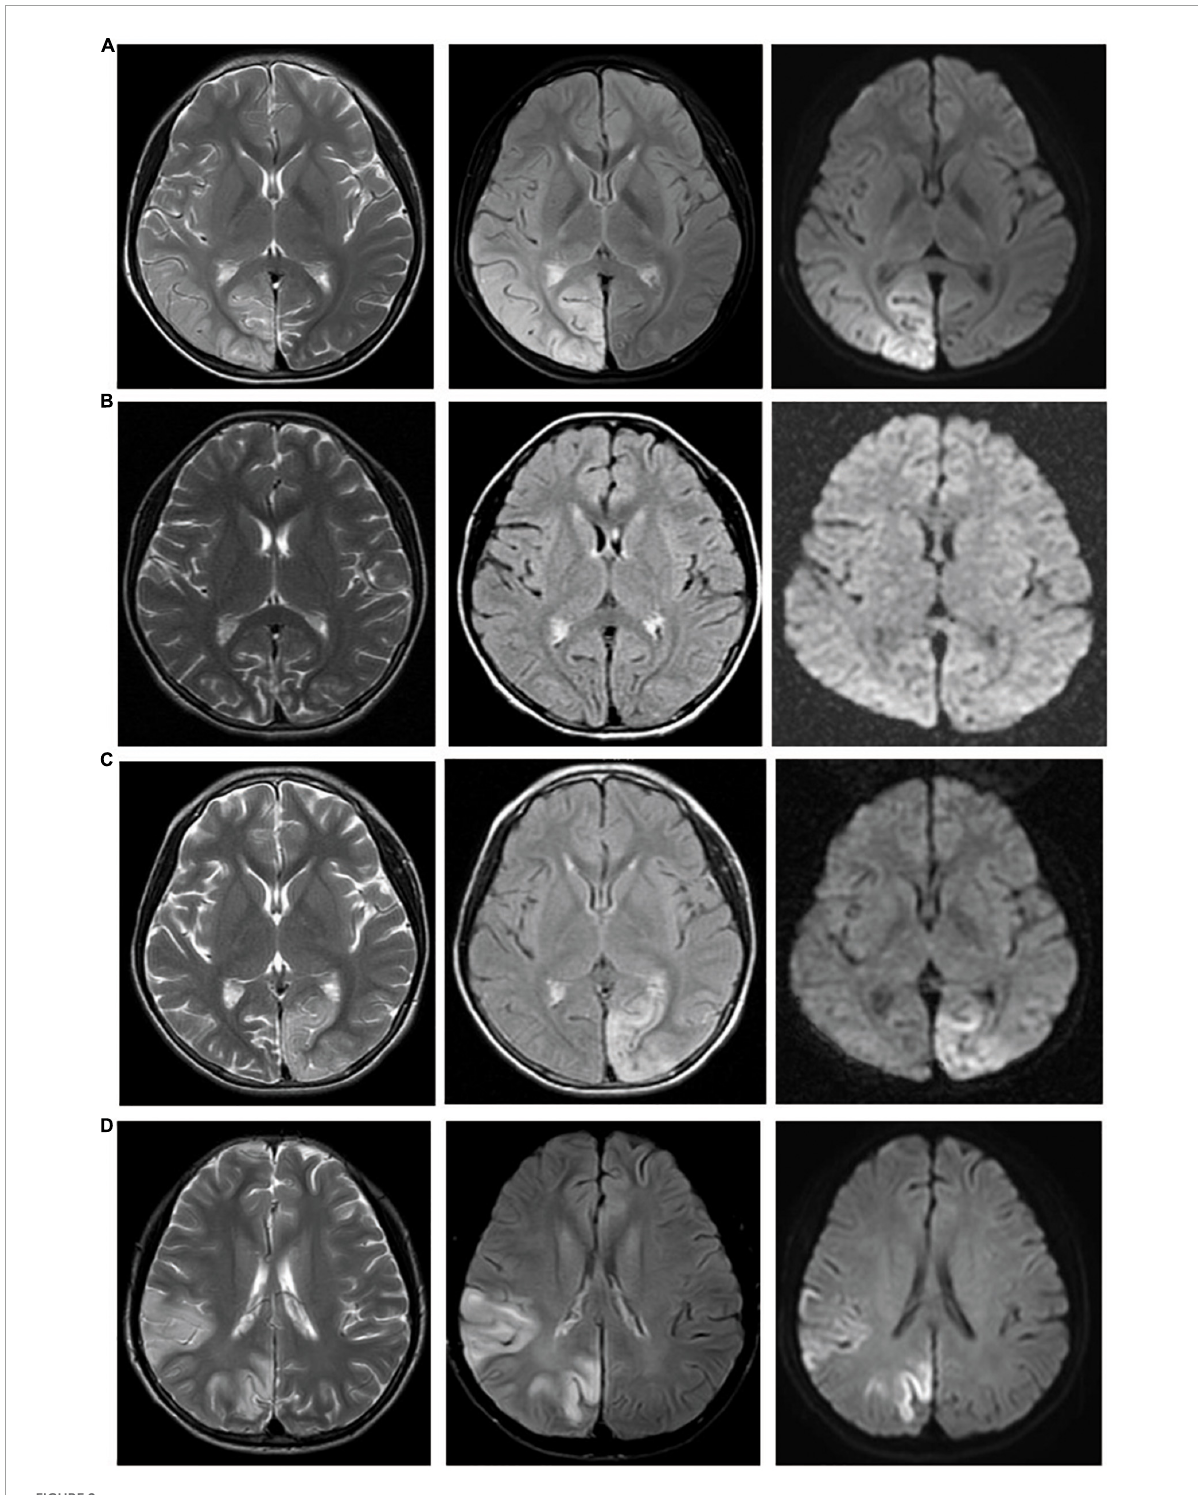
FIGURE2 Lesions migrate over time. Case 6: Four MR examinations were conducted successively in a 10-year-old girl with MELAS from 2014 to 2016. (A) Abnormal signal in the right temporal, parietal, and occipital lobes. (B) Forty-eight days later, MR showed cerebral atrophy, and the abnormal signal in the right temporal, parietal, and occipital lobes disappeared. (C) Eighty-seven days later, a new lesion appeared in the left parietal and occipital lobes. (D) More than 2 years later, lesions in the left parietal and occipital lobes appeared, and new lesions appeared in the right temporal, parietal, and occipital